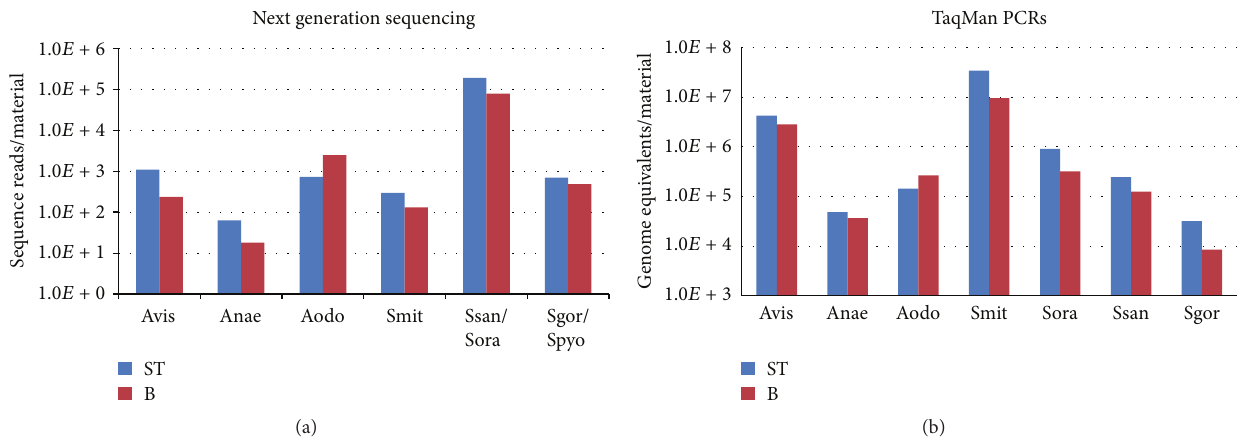
Figure 4: Comparison of NGS and TaqMan-PCR. (a) NGS and (b) TaqMan-PCR for materials ST and B. A . viscosus (Avis), A. naeslundii (Anae), A. odontolyticus (Aodo), S. mitis (Smit), S. oralis / S. sanguinis (Ssan/Sora), and S. pyogenes/S. gordonii